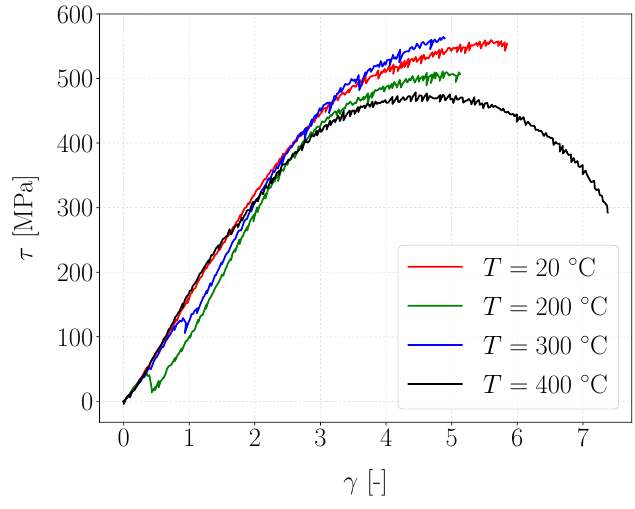
Figure 8. Shear stress τ vs. shear strain γ curve using (1) and